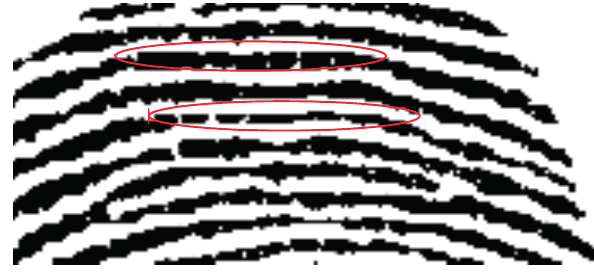
Figure 3. Arch-top patterns of a